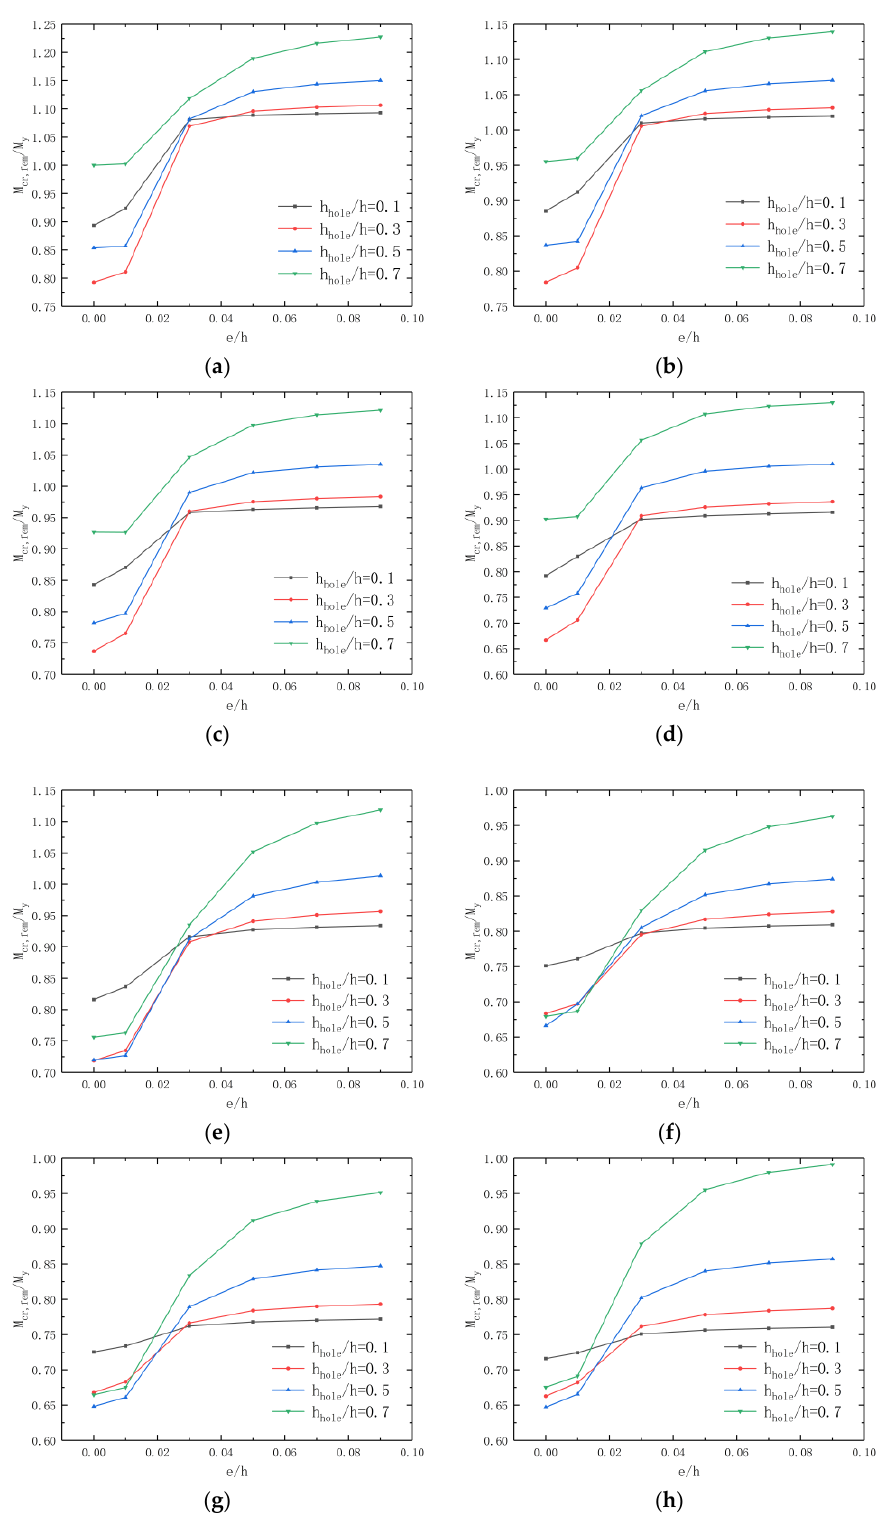
Figure 12. Effect of 𝑒/ℎ ratio on moment capacity. ( a ) Section A (L = 400). ( b ) Section B (L = 400). ( c ) Section C (L = 400). ( d ) Section D (L = 400). ( e ) Section A (L = 600). ( f ) Section B (L = 600). ( g ) Section C (L = 600). ( h ) Section D (L = 600)